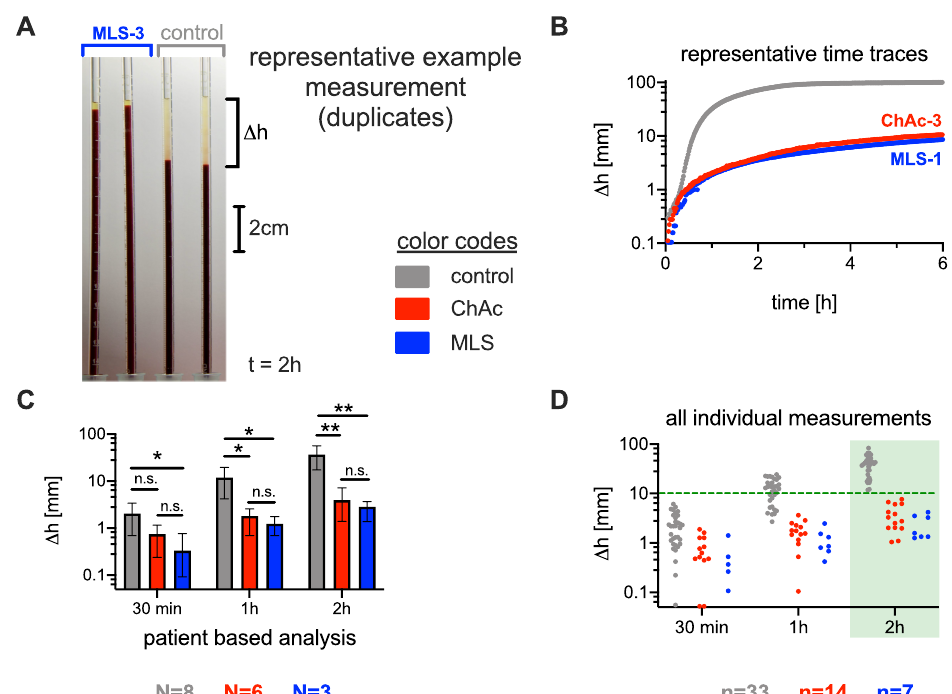
Figure 1. Comparison of the erythrocyte sedimentation rate (ESR) between neuroacanthocytosis patients and healthy controls. ( A ): ESR measurement setup: Standard Westergren tubes were filled with full blood and left to rest. The sedimentation height was measured over time. The picture was taken after 2 h. The first two tubes contain blood from an MLS patient, and the last two tubes contain blood from a healthy control donor. ( B ): Representative time traces of the sedimentation height for the different conditions. ( C ): Statistics on sedimentation height after typical times for healthy controls, chorea-acanthocytosis (ChAc) patients, and McLeod syndrome (MLS) patients. The bar height represents the average value, and the error bar depicts the range of individual values. Stars indicate the significance levels (Brown–Forsythe and Welch analysis of variance (ANOVA) test): n.s., not significant ( p -value > 0.05); * p < 0.05; and ** p < 0.01. N refers to the number of patients. ( D ): Span of all individual sedimentation height measurements (each blood sample was measured at least in duplicate, and the blood of some patients was measured at different time points). After 2 h, a ∆ h of 10 mm could be regarded as a threshold to differentiate the ChAc and MLS conditions. The number n refers to the number of individual measurements out of the same number N of